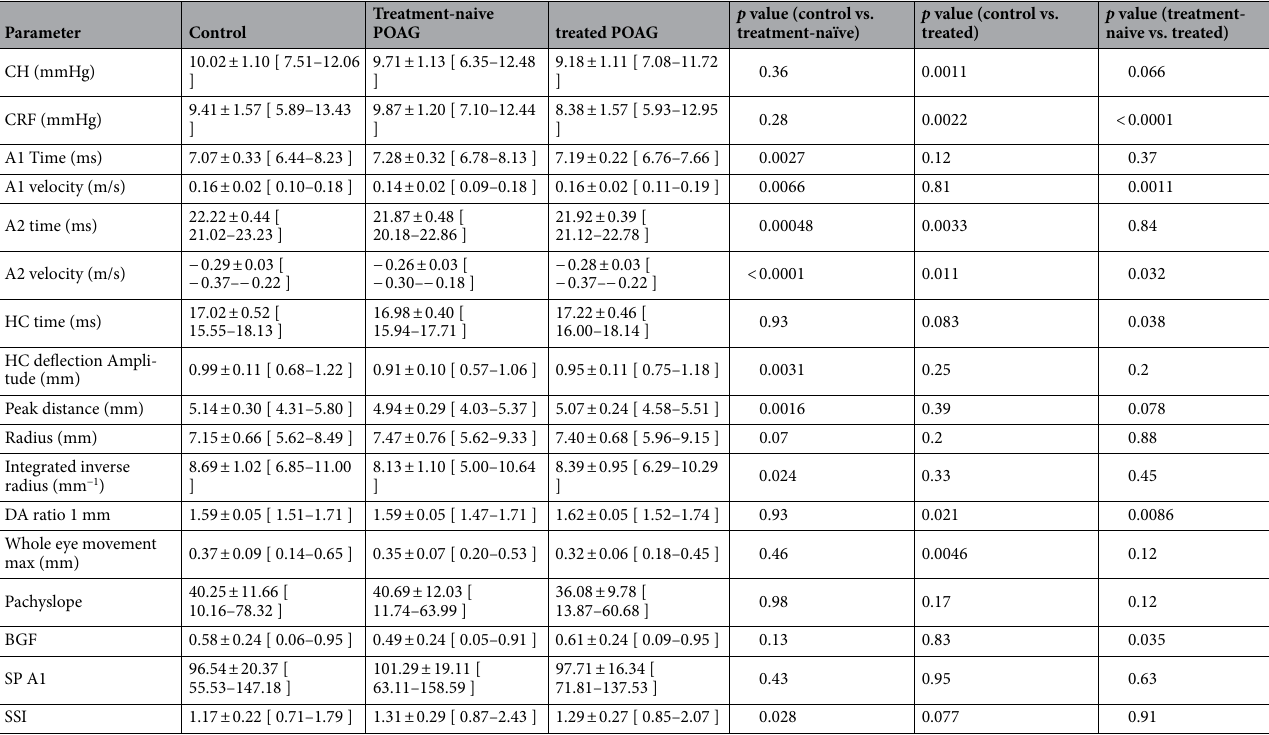
Table 3. comparisons of biomechanical parameters measured with ORA and Corvis ST. BGF biomechanical glaucoma factor; CH corneal hysteresis; CRF corneal resistance factor; DA deformation amplitude; HC